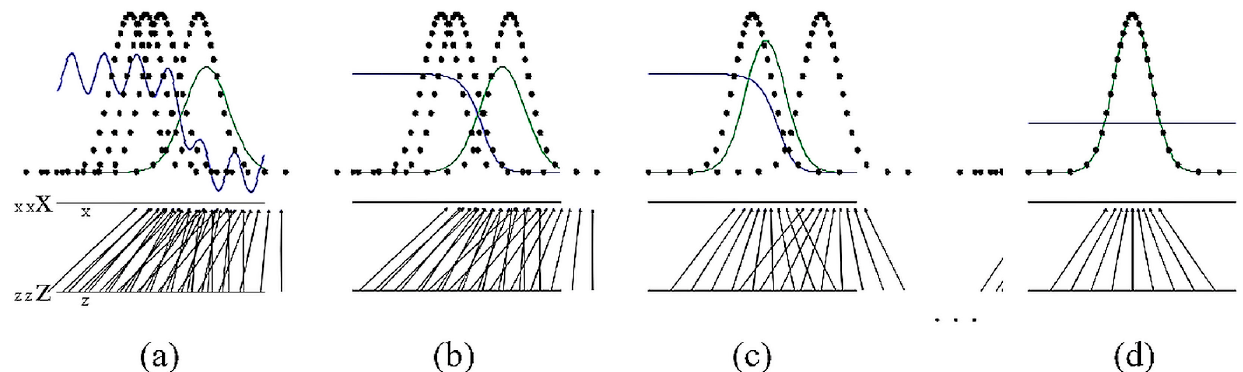
Figure 2. Training of generative adversarial networks by updating the discriminative distribution. Generative adversarial networks are trained by updating the discriminative distribu- tion. These are shown by the blue line in Figure 2 in order to distinguish it from the data generative distribution, shown in the green line. Finally, the actual data is shown using the black dotted line. The horizontal lines in the lower portion show the mapping from the distribution of z to that of x . It can be seen that the data were mapped uniformly [14]. The different figures are alike; Figure 2a shows a fairly decent discriminator, while the